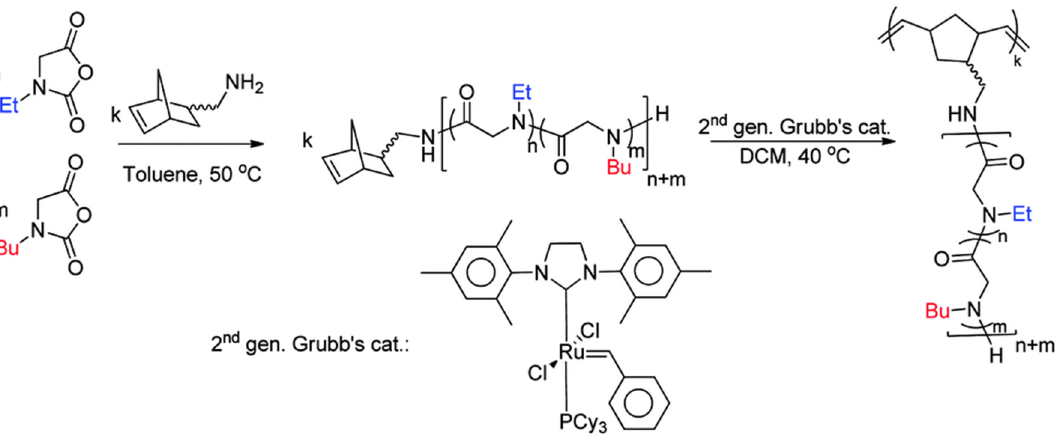
Figure 12. Synthesis of thermo-responsive polypeptoid bottlebrushes (ref. [85]. Copyright 2014, Royal Society of Chemistry).